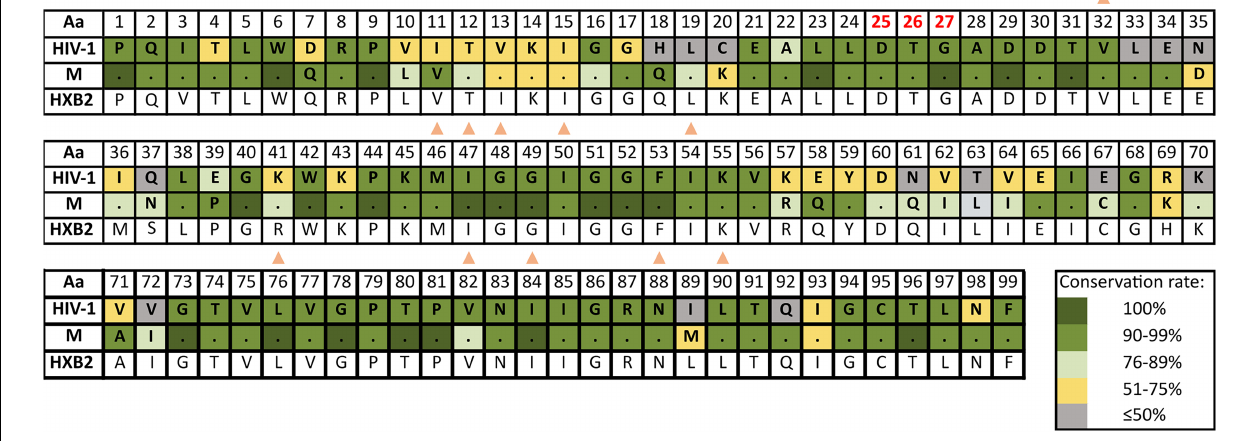
Frontiers in Microbiology |